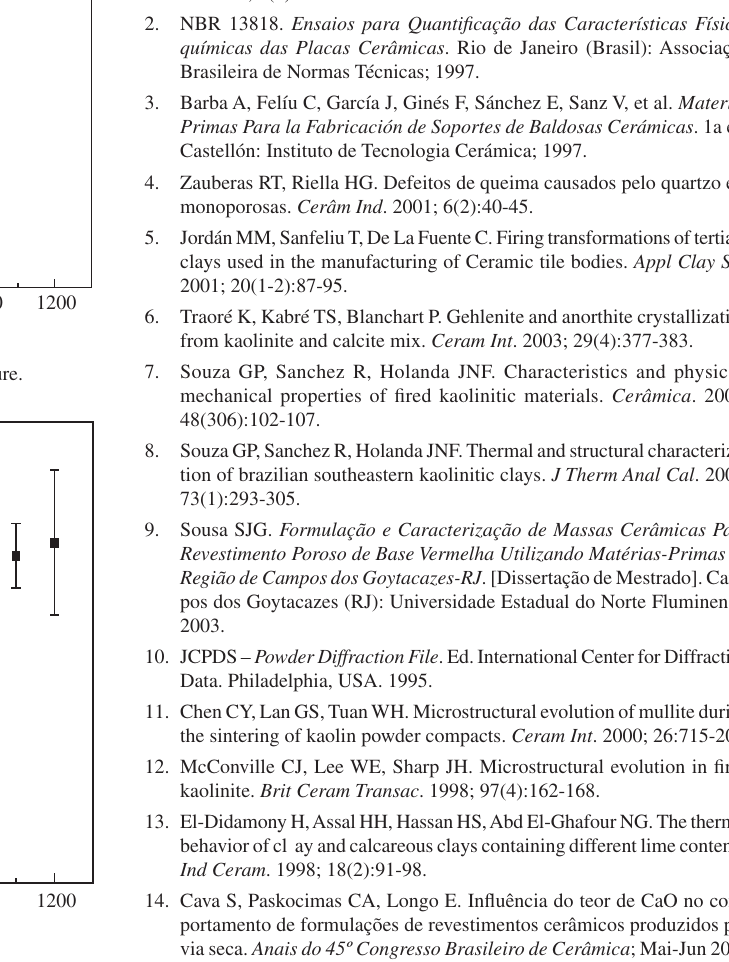
Figure 8. Flexural strength as a function of sintering